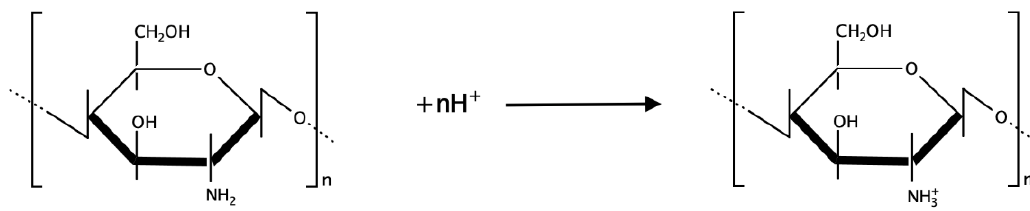
Figure 6. pH effect on chitosan. (Adapted with permission from [17], Copiright 2001, John Wiley and Sons)